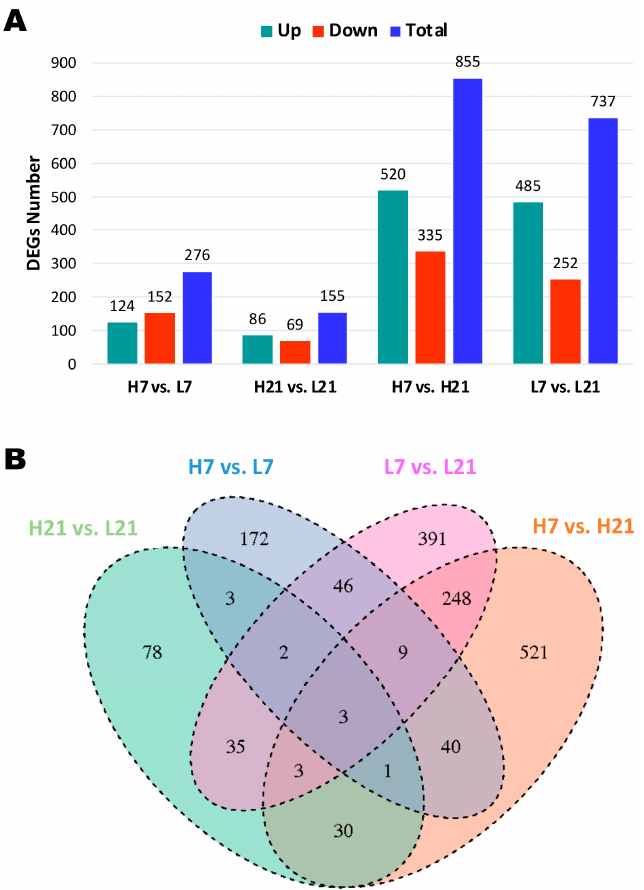
Figure 2. Identification of differentially expressed genes (DEGs) in low and high H/L ratio chicken groups at 7 and 21 dpi. ( A ) Summary of total DEGs between low and high H/L ratio groups. ( B ) Venn diagram showing the number of unique and shared DEGs between different groups. H7: High H/L SE-infected 7 dpi (n = 6); L7: Low H/L SE-infected 7 dpi (n = 7); H21: high H/L SE-infected 21 dpi (n = 5); L21: Low H/L SE-infected 21 dpi (n = 4).